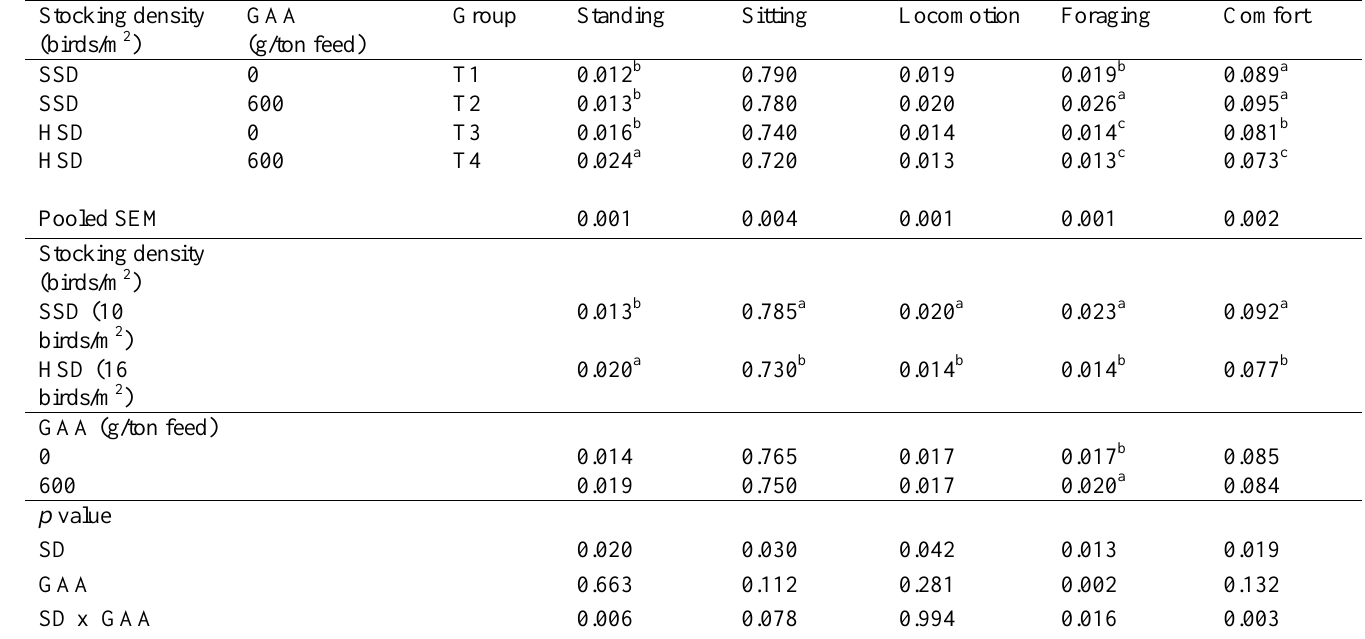
Table 3: Effect of stocking density and GAA supplementation on behavioral patterns proportion: